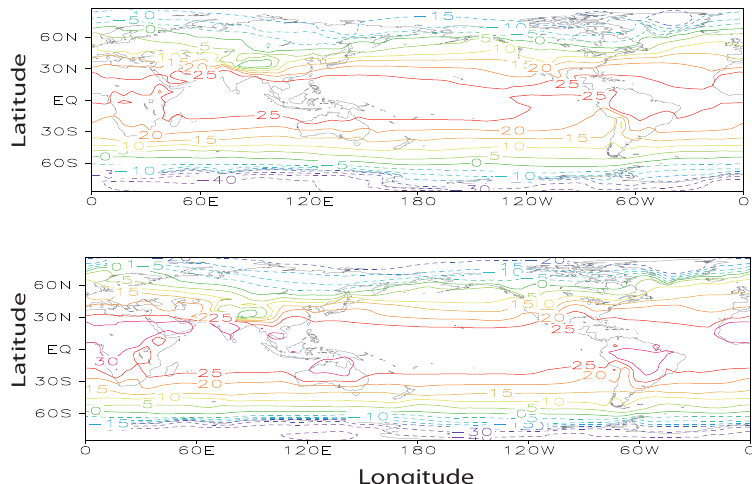
Fig. 9. Surface temperature (°C) averaged over the period 1980-2000 in (a) HADCRUT3 dataset (Brohan et al. 2006) and in (b) LOVECLIM1.2.